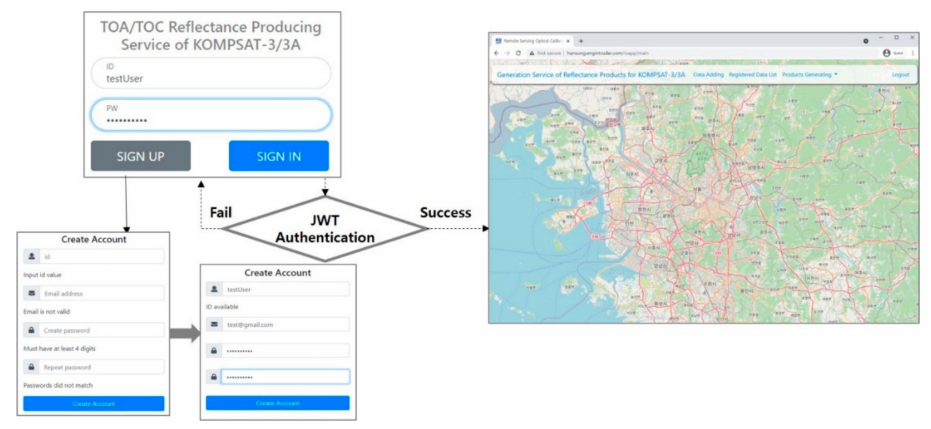
Figure 5. SaaS activation: sign-up and sign-in processes on OpenStreetMap (OSM) as the base